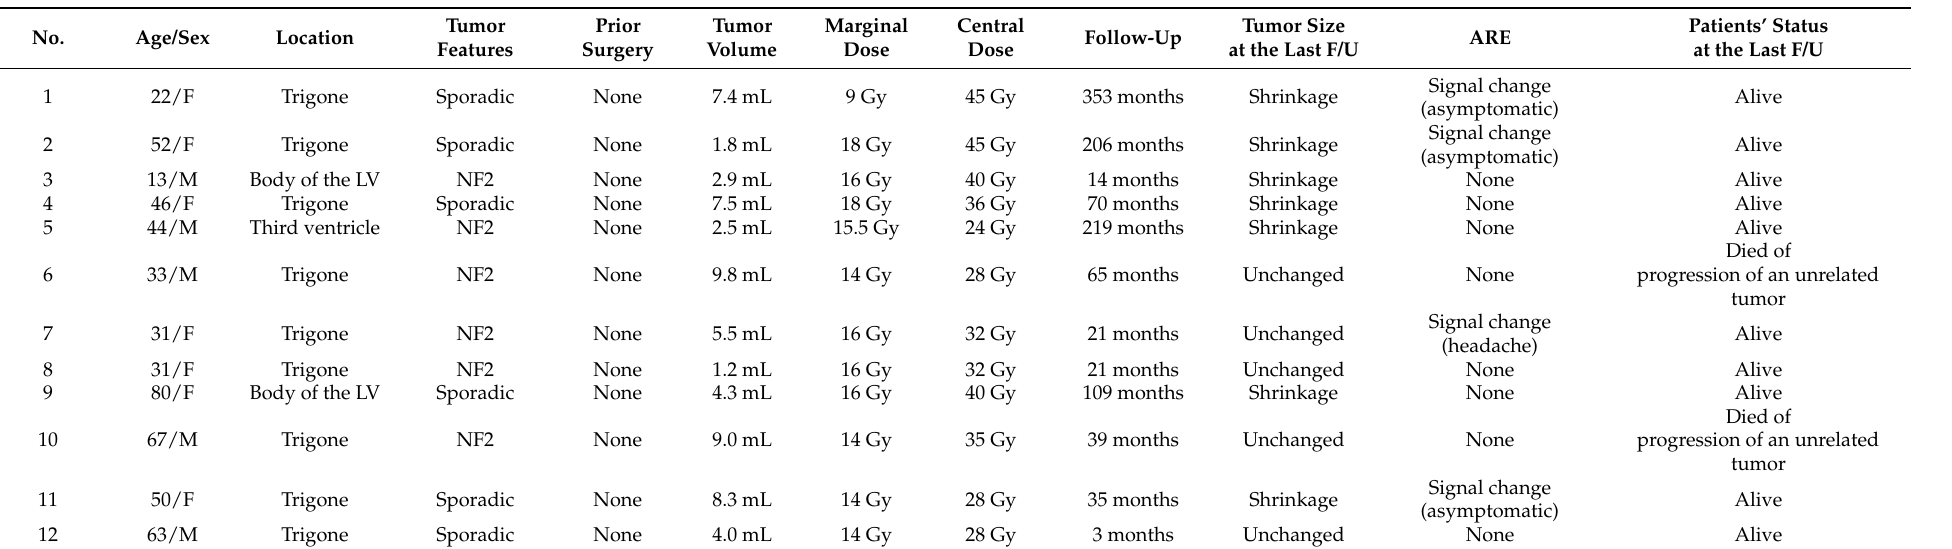
Table 2. Summary data of all intraventricular meningiomas treated with stereotactic